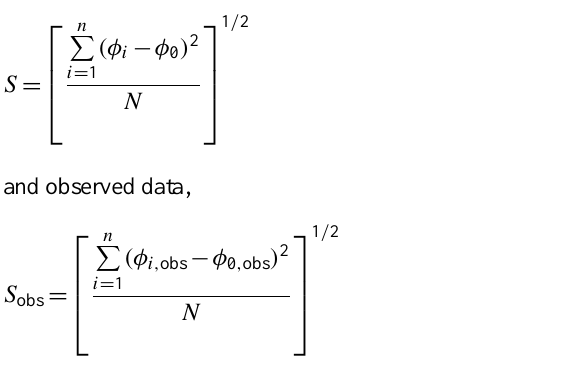
Fig. 3. Difference ( % ) between area-averaged precipitable water in the GFS forecast and analysis for a domain covering the Madeira Island. GFS forecasts start from day 13 (Run6) until day 20 (RunPrev).